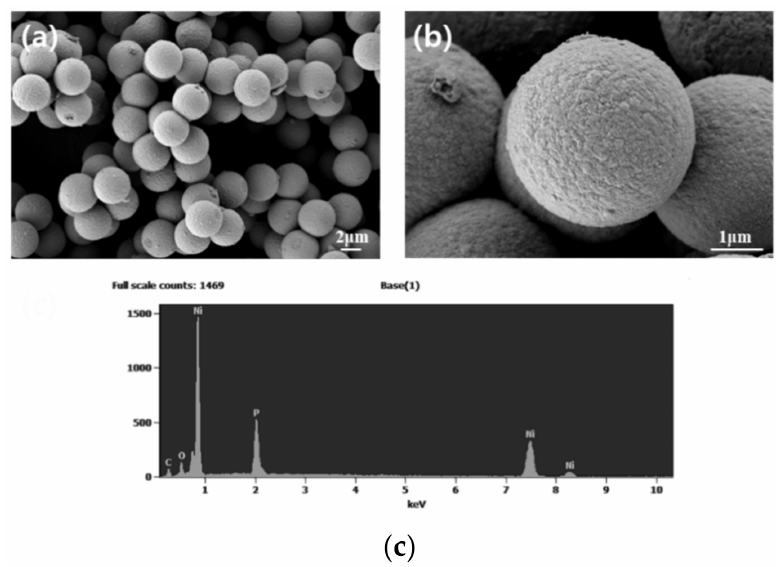
Figure 10. SEM image and EDS graph of metal coating, with optimizing concentration after calcu- lating the specific surface area: ( a ) image taken at 8.0 K magnification, ( b ) image taken at 40.0 K magnification, and ( c ) surface composition analysis graph, using EDS.